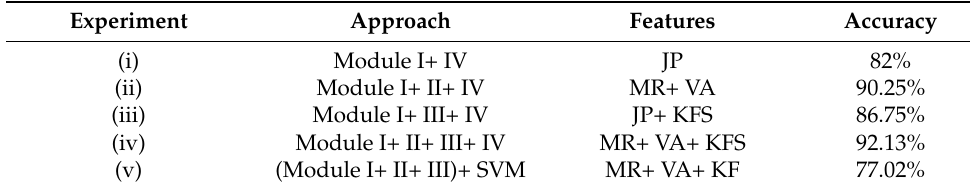
Table 9. Comparison of methods on self-made datasets. The results are presented in the order of experiments (i–v), and the result of using the completed architecture we proposed in Figure 2 is shown in bold text. Note: joint points (JP), module ratio (MR), vector angle (VA), keyframe sequences (KFS), keyframes (KF). For more details, see Sections 4.2 and